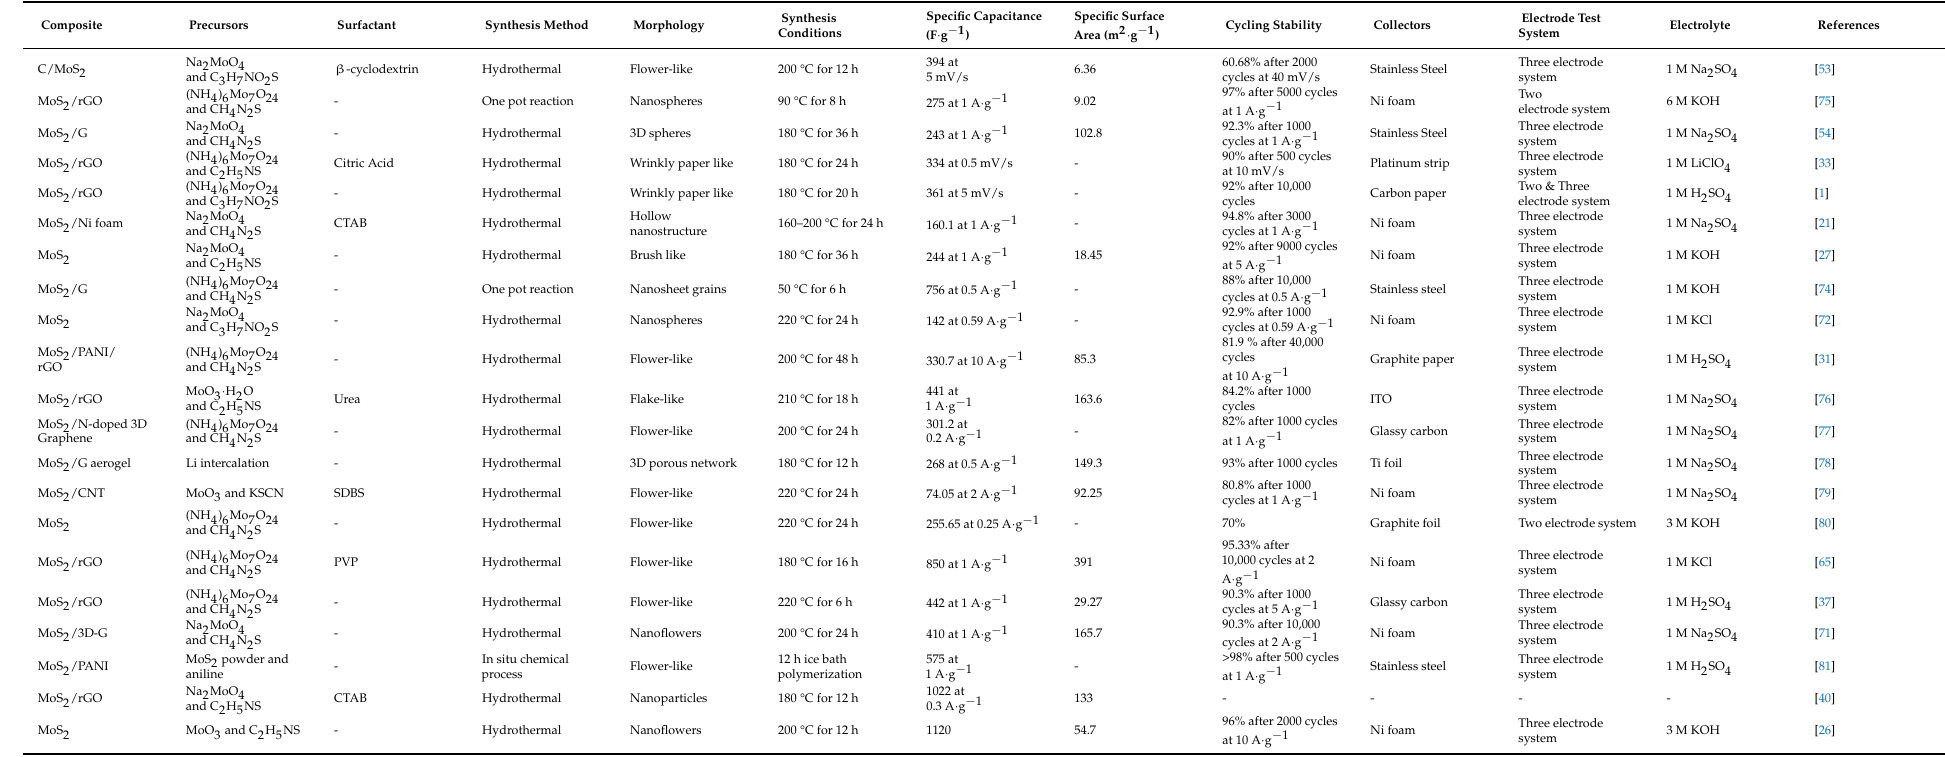
Table 1. Various results from literature on electrode materials based on MoS 2 composites for supercapacitor